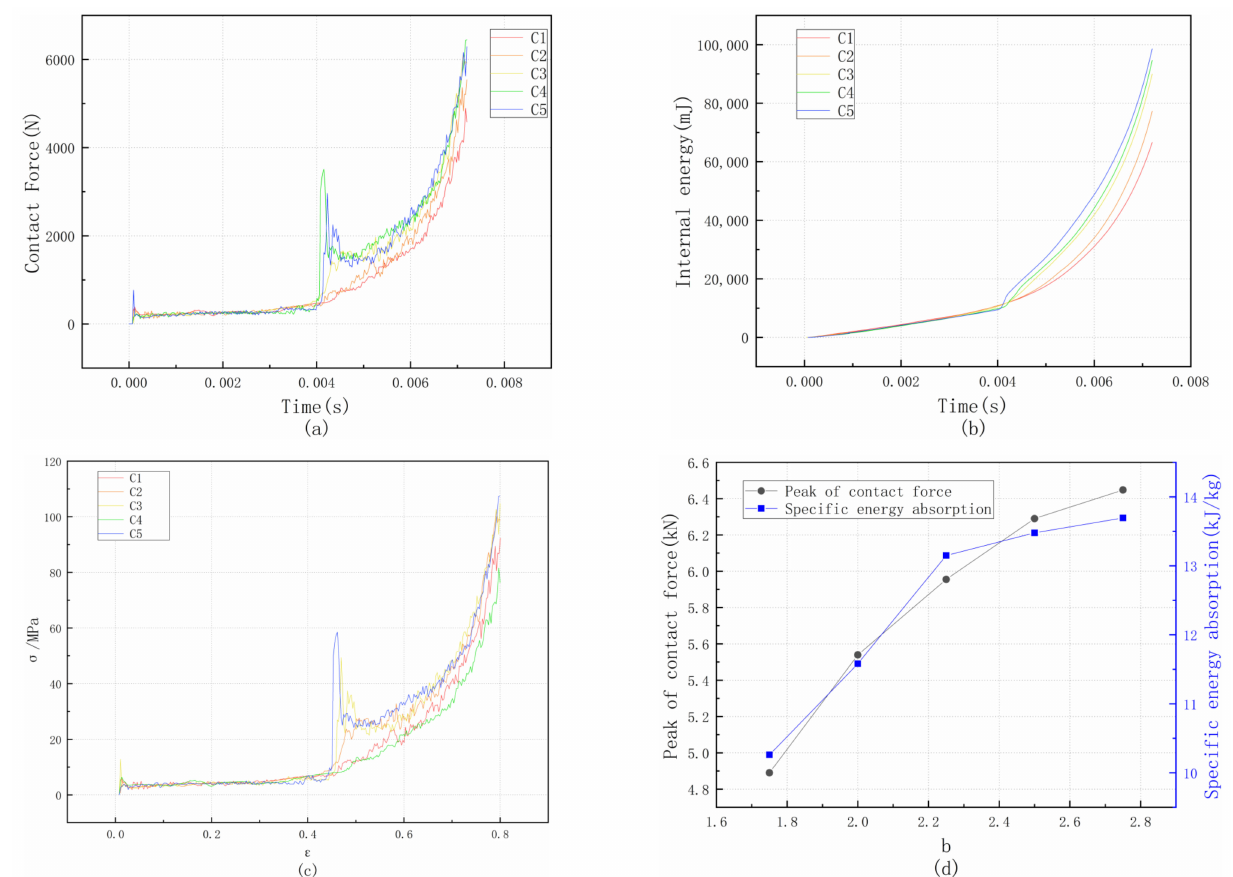
Figure 17. ( a ) Effect of different b on force; ( b ) effect of different b on energy; ( c ) effect of different b on stress–strain curve; ( d ) effect of different b on peak crushing force and specific absorption energy.